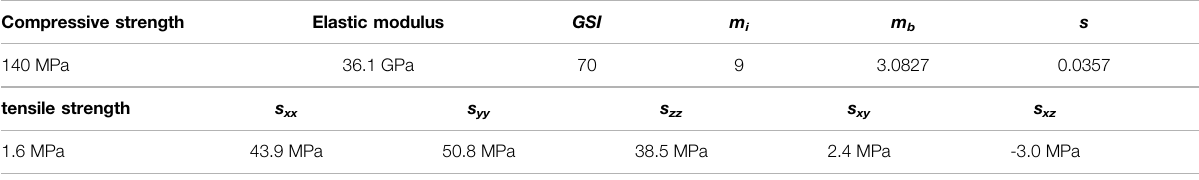
TABLE 2 | Hoek-Brown mechanical parameters and in-situ stress fi eld at K11+105 cross section. Compressive strength